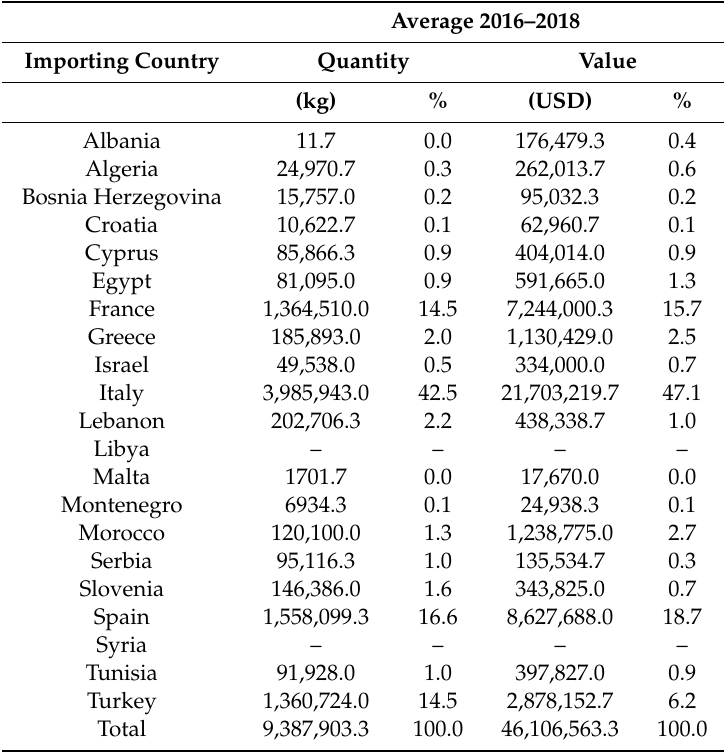
Table 4. Total quantity and value of imports in Mediterranean countries of plant material for non-food uses (United Nations (UN) Comtrade code 06) from countries with X. citri